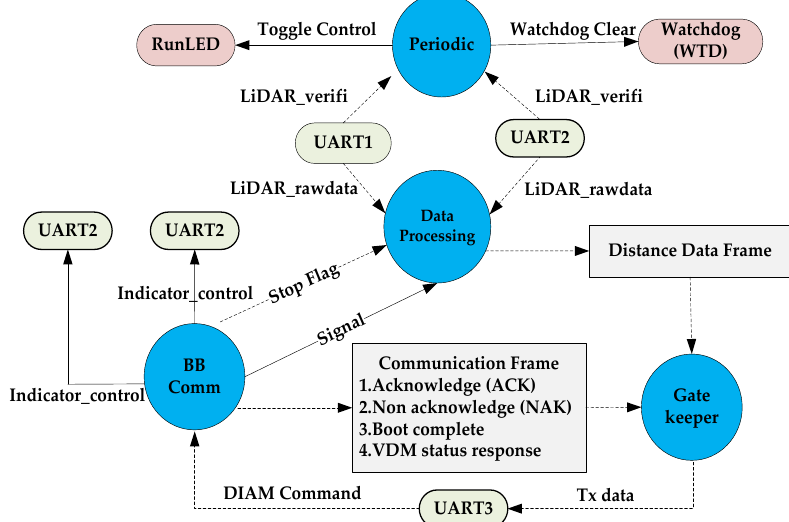
Figure 4. Vehicle detection module ( VDM) data flow diagram.